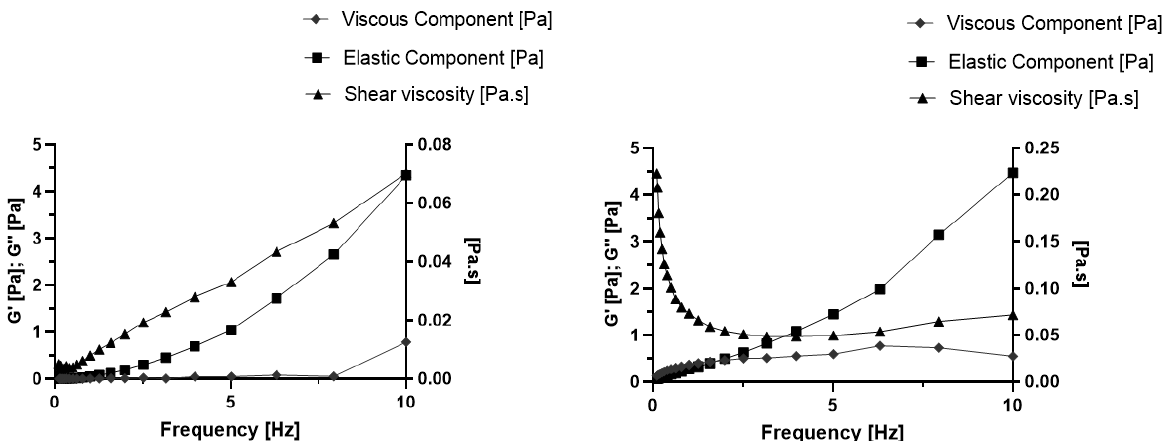
Figure 4. Rheological behavior of CBD-cSLN ( left-hand ) and CBD-cNLC ( right-hand ) over a frequency range of 0–10 Hz.